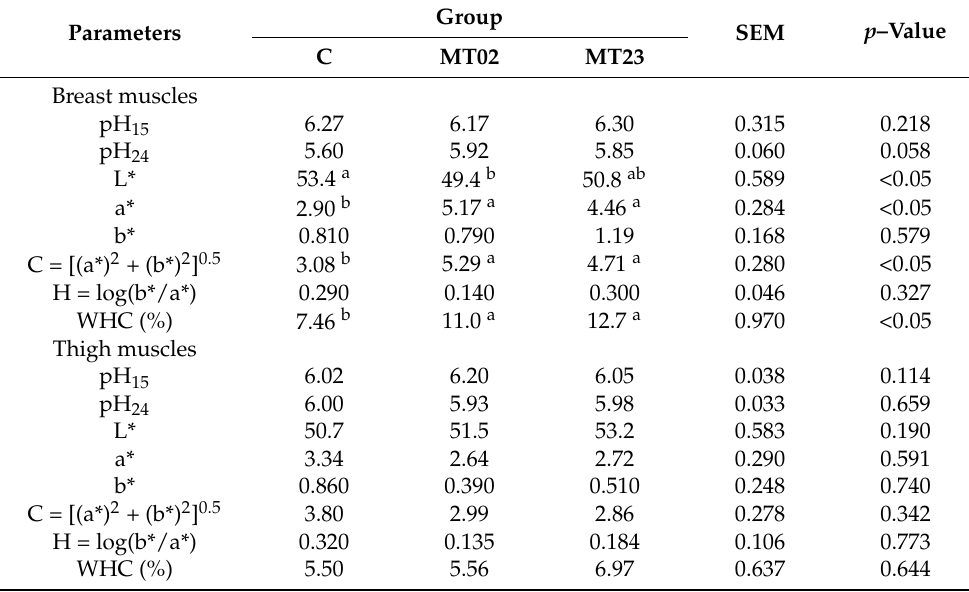
Table 7. Physical parameters of muscles.